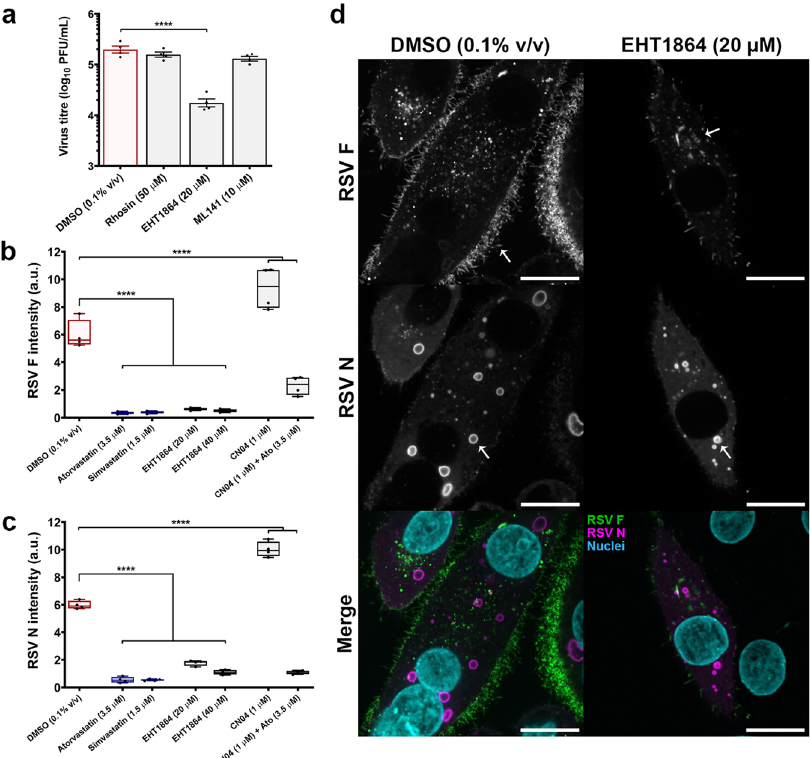
Fig. 7 Rac1 inhibition disrupts surface expression of the F protein and infectious virus production. a Infectious virus production was quanti fi ed by plaque assay from the supernatants of RSV A2-infected HEp-2 cells treated with inhibitors of RhoA (Rhosin, 50 µ M), Rac1 (EHT 1864, 20 µ M), or Cdc42 (ML 141, 10 µ M). Rac1 inhibition by EHT 1864 (20.0 µ M) caused a signi fi cant reduction in infectious virus production. Values are reported as means ± SEM ( n = 4 independent measurements). b , c HEp-2 cells were infected with RSV A2 (MOI 0.5) and viral protein intensity was quanti fi ed by immuno fl uorescence 48